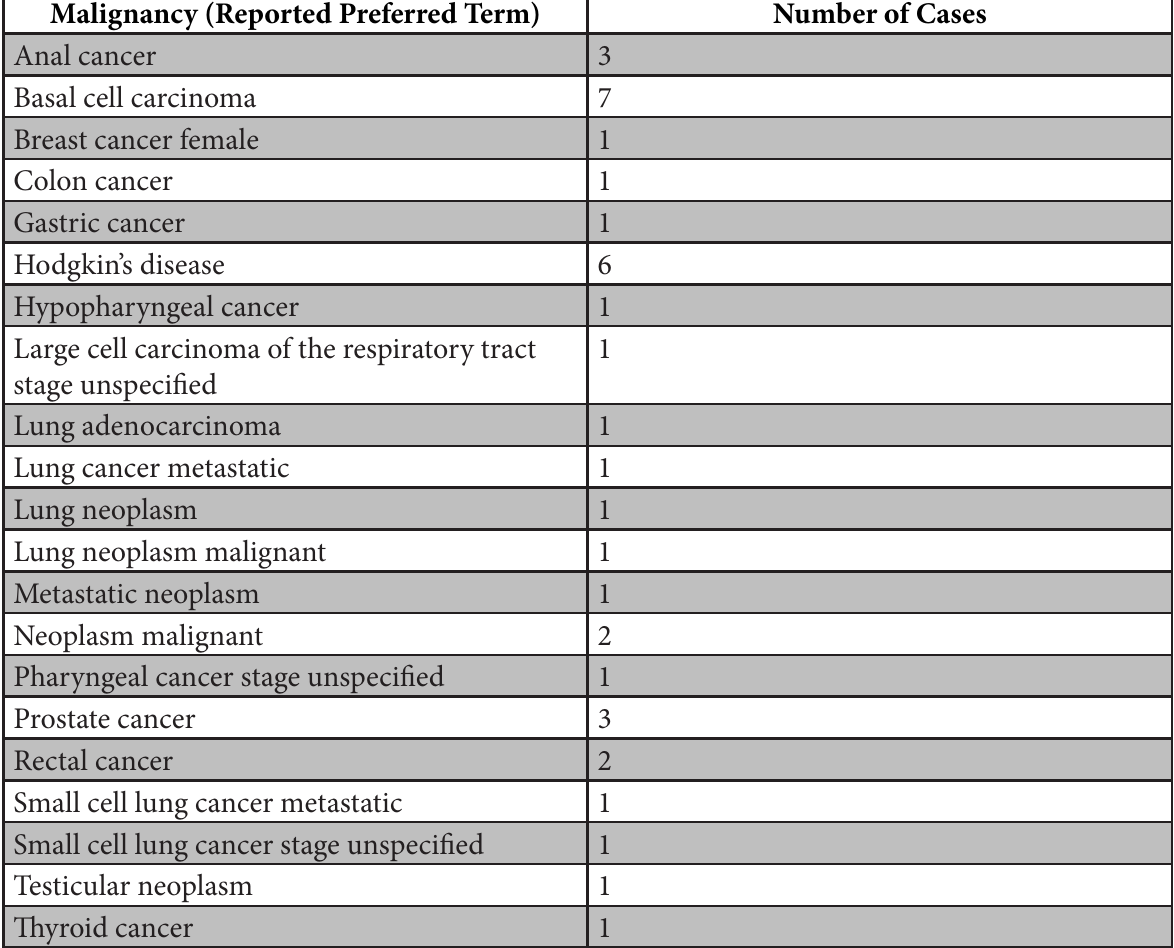
Supplementary Table 1. Specific Malignancies Reported Among Case